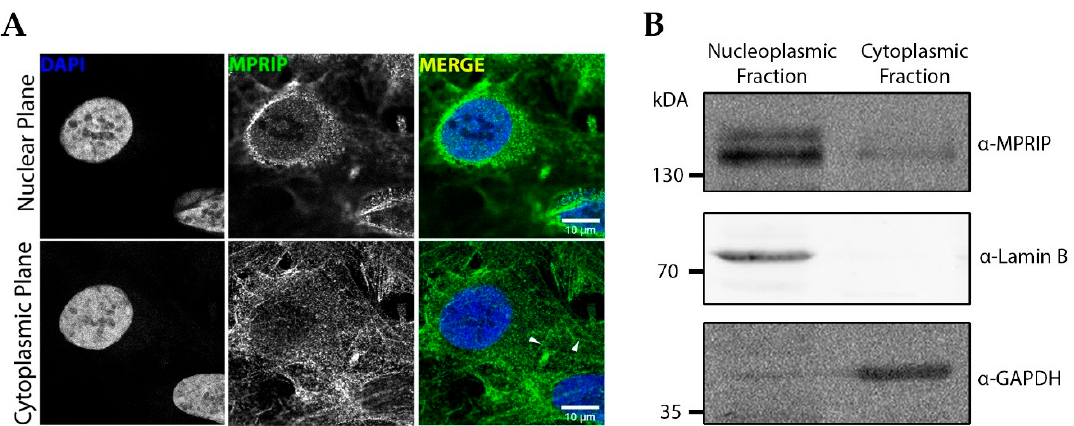
Figure 1. Myosin phosphatase rho-interacting protein (MPRIP) localizes to the cytoplasm and cell nucleus: ( A ) confocal microscopy of an immunofluorescence (IF) experiment shows the localization of endogenous MPRIP in U2OS nucleus and cytoplasmic stress fibers. Upper and lower images represent different focal planes: nuclear and cytoplasmic, respectively. Arrowheads point to the MPRIP staining on stress fibers. Scale bars represent 10 µ m; ( B ) Western blot (WB) of HeLa cells fractionated to nuclear and cytoplasmic fractions with detected MPRIP, Lamin B and GAPDH by a specific antibody ( n = 3).